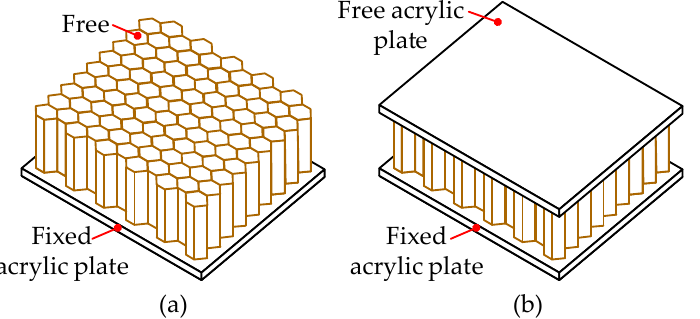
Figure 9. Illustration of boundary conditions for the honeycomb: ( a ) BC1; ( b ) BC2.